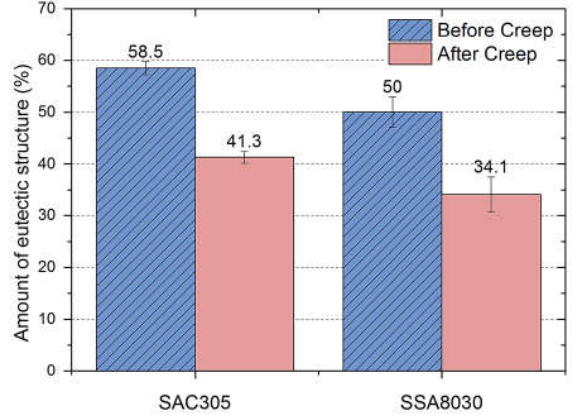
Figure 8. The amount of eutectic microstructure before and after creep testing at 175 °C. The bars correspond to standard deviations.